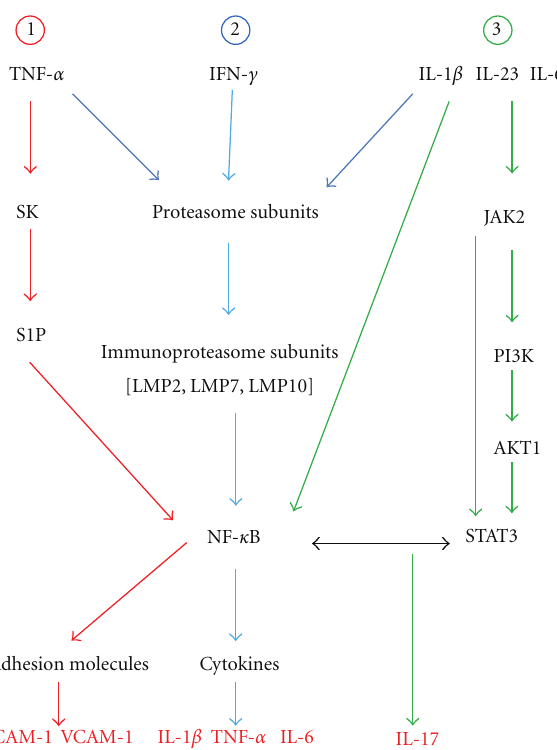
Figure 2: This figure shows three novel intracellular signaling pathways involved in the pathogenesis of IBD. Pathway 1: TNF- α induces adhesion molecule expression in endothelial cells, as well as proinflammatory cytokine (IL-1 β , IL-6) production by monocytes, through a sphingosine kinase (SK), sphingosine-1-phosphate (S1P), nuclear factor-kappa B (NF- κ B)-dependent pathway. Pathway 2: upon stimulation of cells with proinflammatory cytokines (IFN- γ , TNF- α , and IL-1 β ), constitutive proteasome subunits are converted to the immunoproteasome subunits β 1i (LMP2), β 2i (LMP10, MECL-1), and β 5i (LMP7) [38–40]. Functionally, immunoproteasome subunits play a role in NF- κ B signaling. Pathway 3: dual activation of NF- κ B and STAT3 pathways controls the expression of IL-17. As shown in this figure, crosstalk between these three pathways occurs, thereby promoting intestinal inflammation. Specific components of these pathways such as sphingosine kinase (SK), immunoproteasome subunits (LMP2, LMP7, and LMP10), and interactions between NF- κ B/STAT3 represent possible pharmacological targets for IBD. In the figure: LMP is low molecular mass polypeptide (2, 5, or 10); JAK2 is Janus Kinase 2; PI3K is phosphoinositide-3 kinase; AKT1 is Alpha serine/threonine-protein